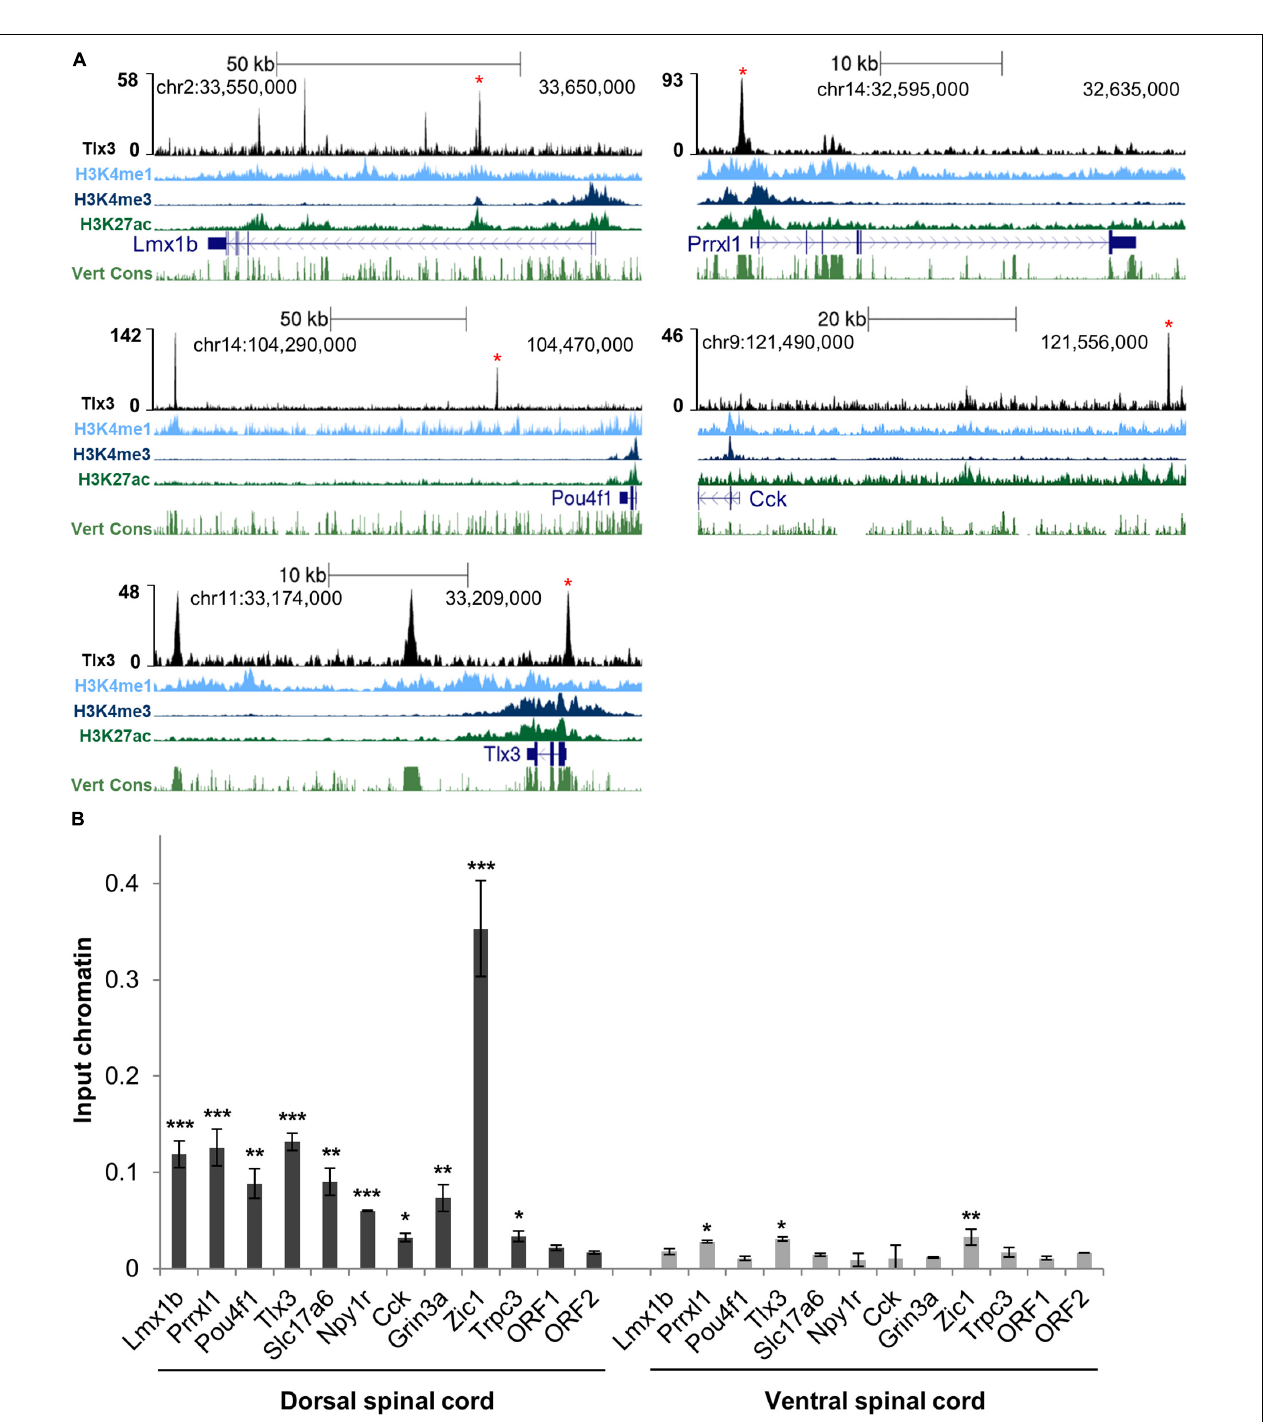
FIGURE 2 | Tlx3 directly controls the expression of transcription factors and terminal differentiation genes involved in glutamatergic differentiation. (A) Tlx3 binding profile (in black) within genomic regions spanning target genes. Target gene structure and direction of transcription (blue), H3K4me1 (light blue), H3K4me3 (blue), and H3K27ac (green), as well as multispecies vertebrate conservation (green) plots are shown. ENCODE annotations are from histone marks of ChIP-seq data sets using E14.5 mouse neural tube (Gorkin et al., 2020). Data tracks extracted using the UCSC genome browser (Waterston et al., 2002). Binding sites validated by ChIP-qPCR are marked by red asterisks. (B) Validation of Tlx3 binding sites by independent ChIP-qPCR using chromatin extracted from either E14.5 dorsal or ventral spinal cords. Two negative control regions (ORF1/2) are shown. Mean ± SD; * P < 0.05, ** P < 0.01, and *** P < 0.001 as compared to ORF2 with Student’s t -test; n = 3 experimental